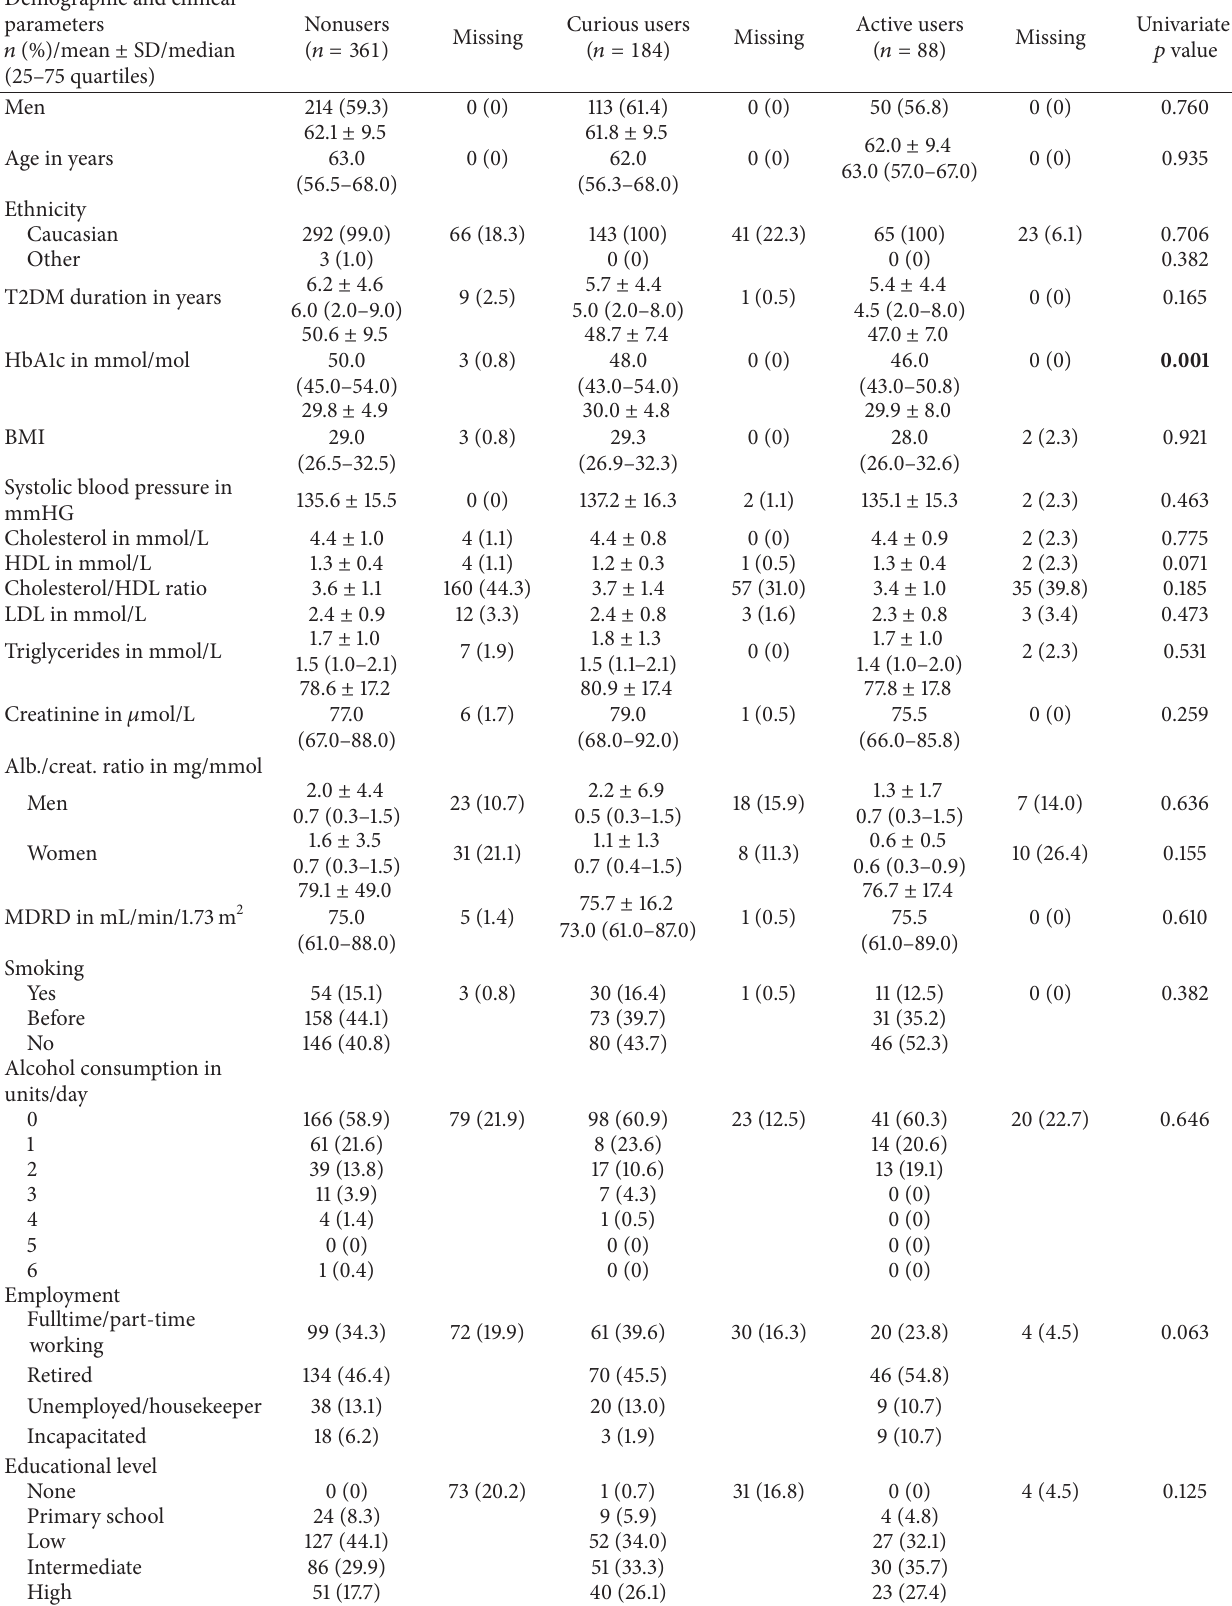
Table 9: Demographic and clinical characteristics of curious users, active users, and